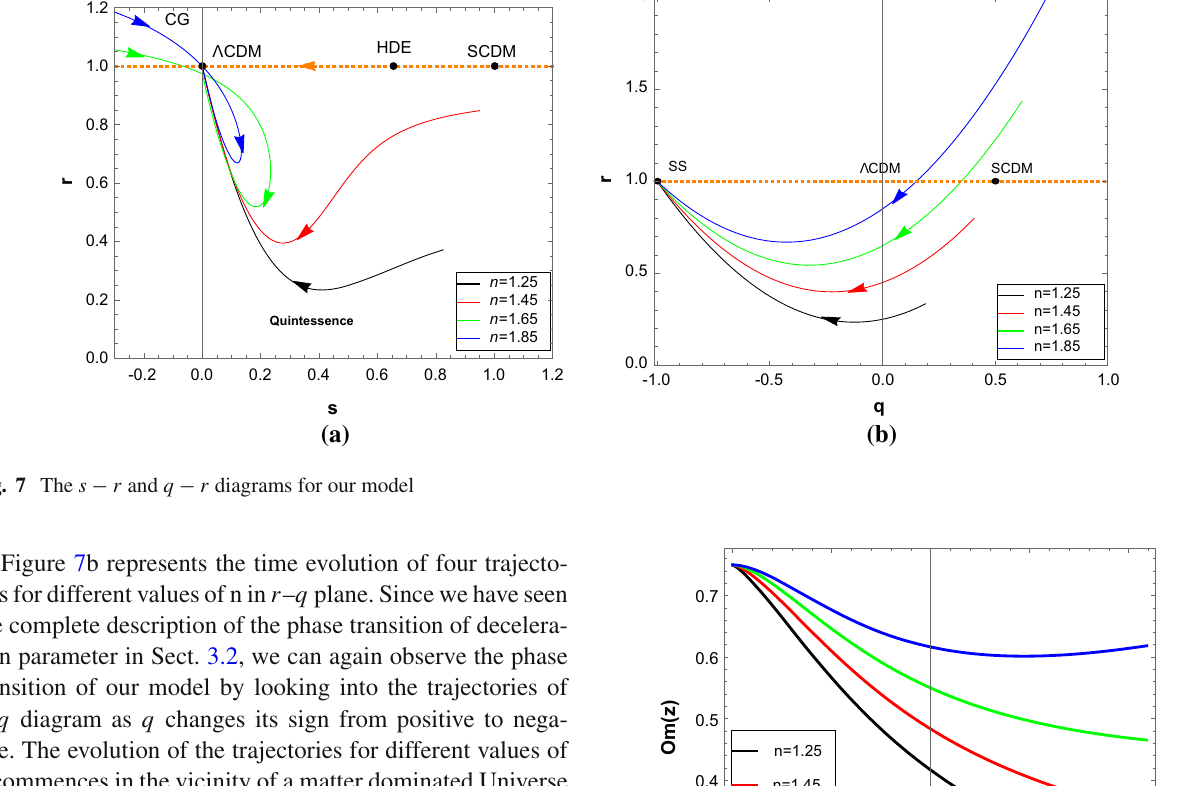
Figure 7b represents the time evolution of four trajecto- ries for different values of n in r – q plane. Since we have seen